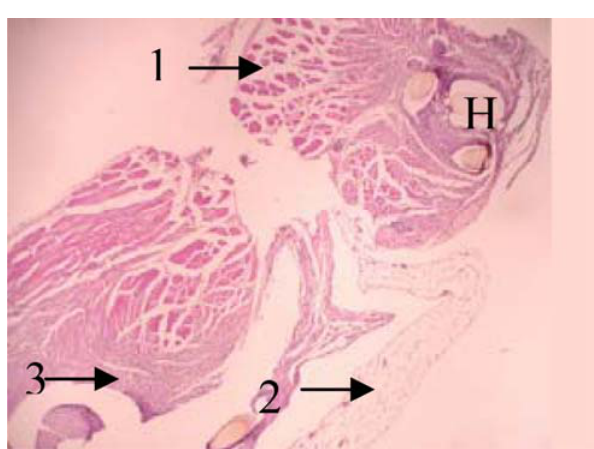
FIGURA 5 - Animal do grupo A - Cortes histológicos de fragmento de tecido constituído por musculatura estriada esquelética (1) e tecido fibroadiposo (2) com vasos ectasiados e granulomas do tipo corpo estranho em torno de fio de sutura e (H) com focos de fibrose (3). Corado por H. E. (x40).